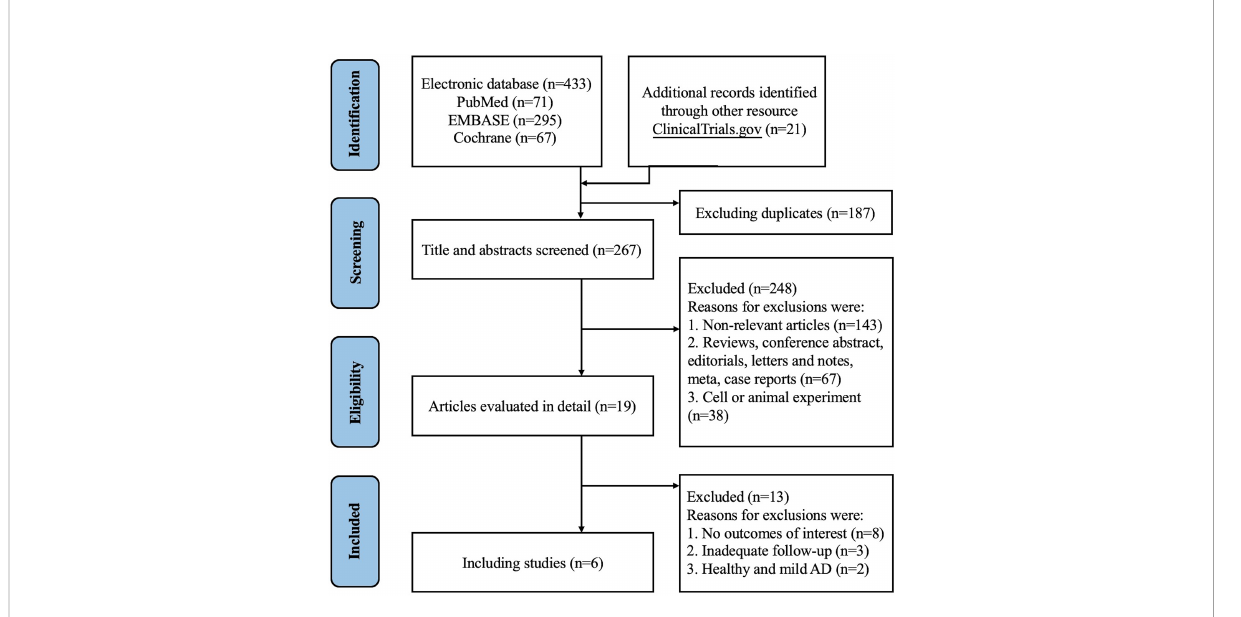
FIGURE 1 PRISM 2020 fl ow diagram for new systematic reviews which included searches of databases and registers